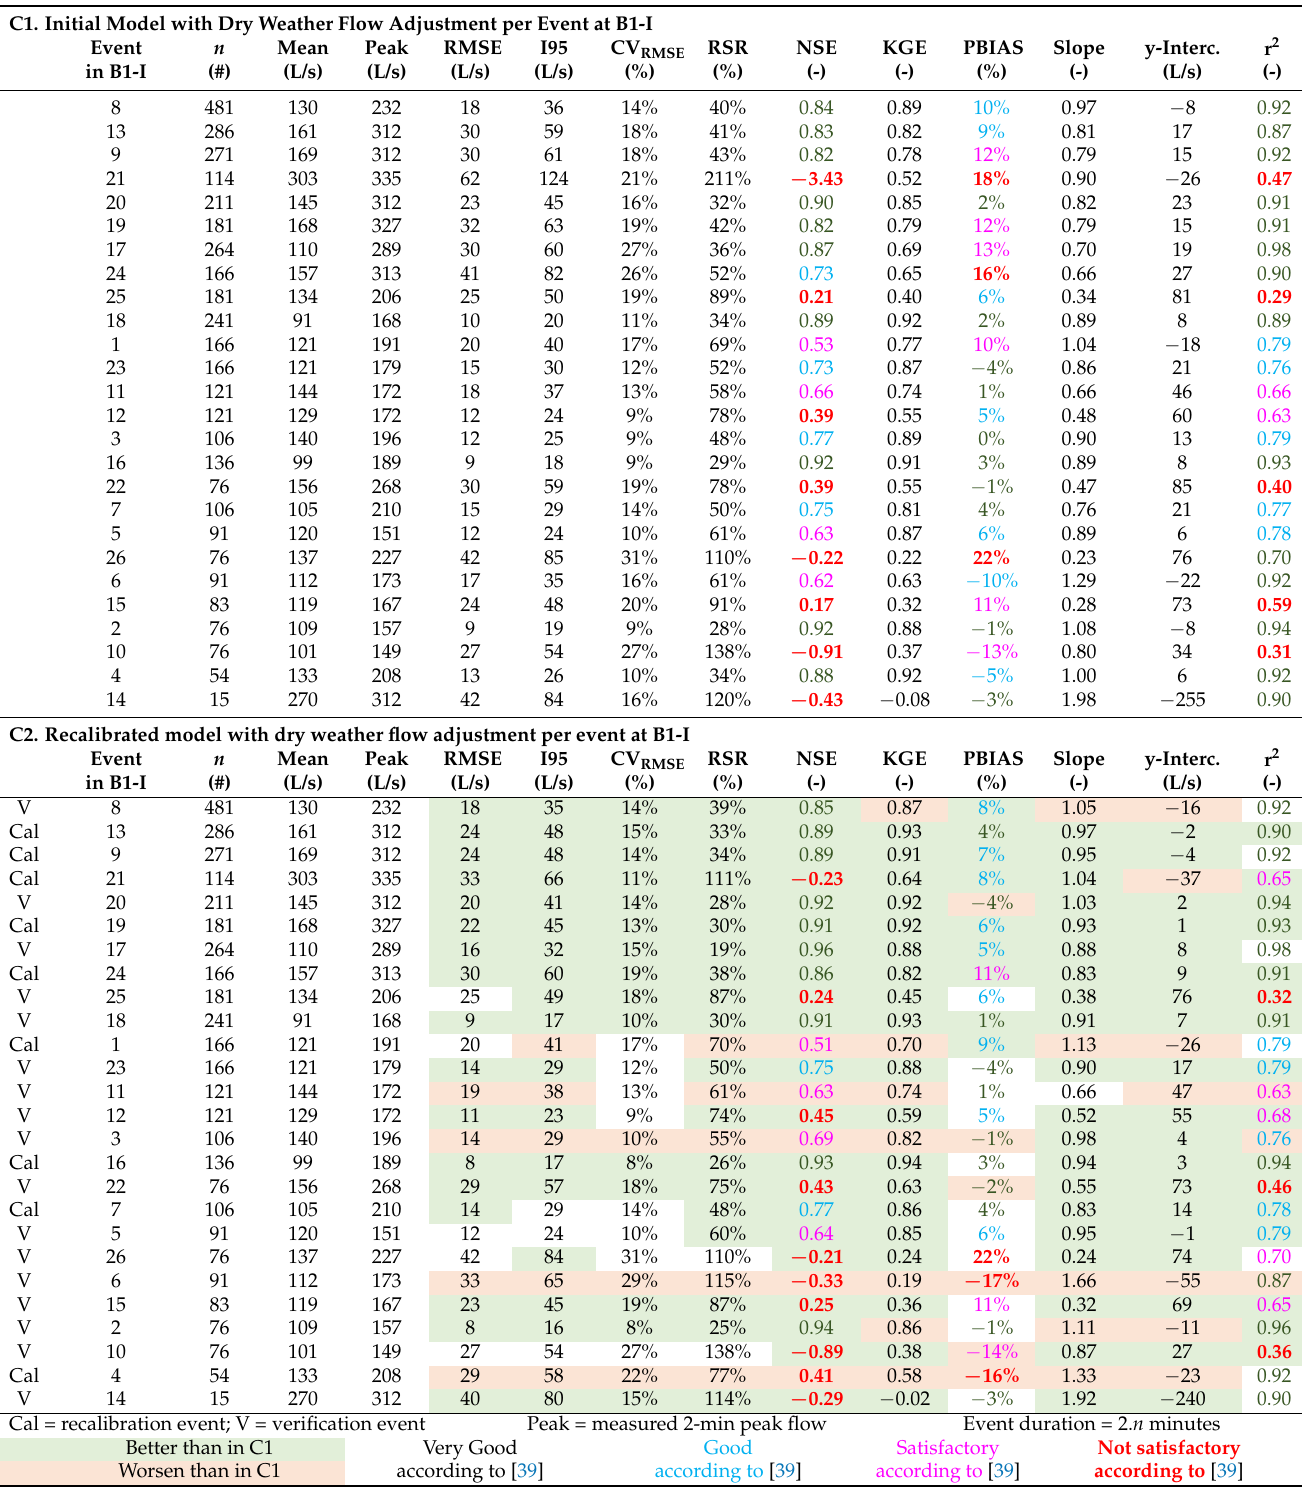
Table A1. Statistical results for all events in B1-I, for the initial and the recalibrated models, both with DWF